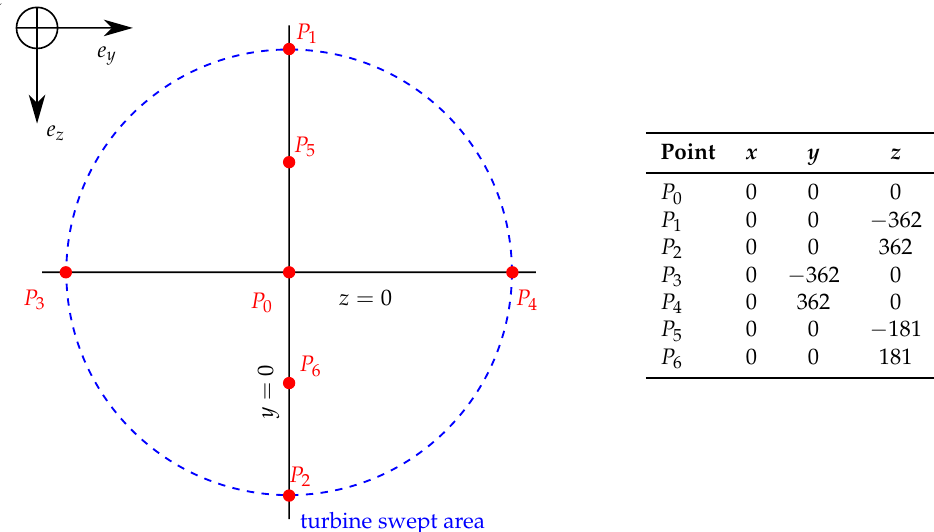
Figure 7. Front view of the ADV measurement points depicted by red circles inside the turbine swept area and their coordinates expressed in